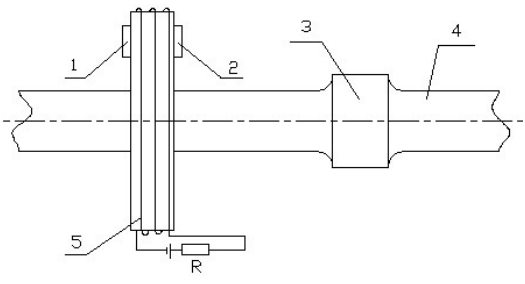
Figure 2. Schematic of contactless detection: 1-magnetoresistive sensor A; 2-magnetoresistive sensor B; 3-drill-stem joint; 4-drill stem; 5-current coil.